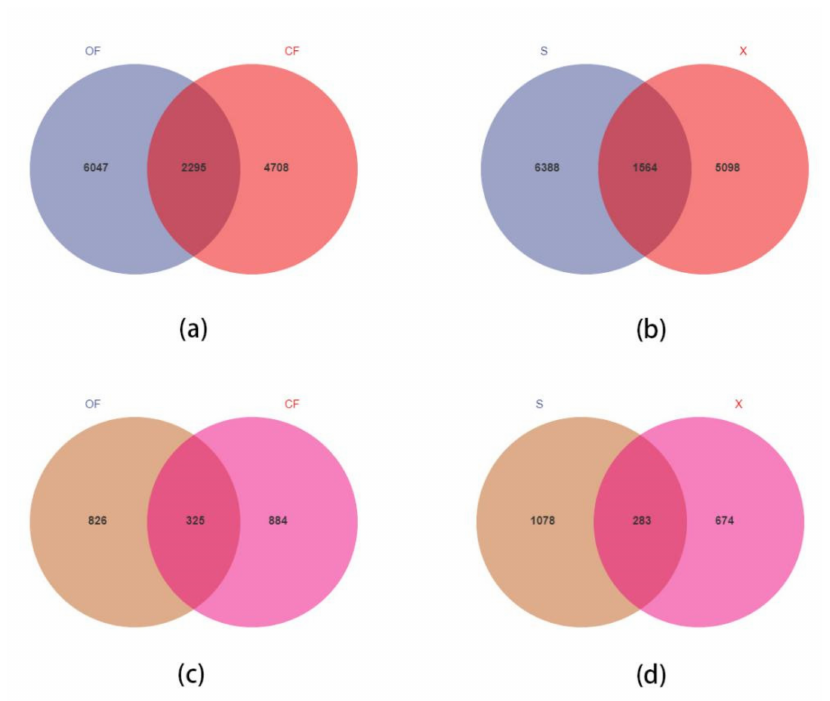
Figure 3. Venn Diagram of soil microorganisms: ( a ) OTU number of bacteria under different cultiva- tion patterns; ( b ) OTU number of bacteria in different soil layers; ( c ) OTU number of fungi under different cultivation patterns; ( d ) OTU number of fungi in different soil